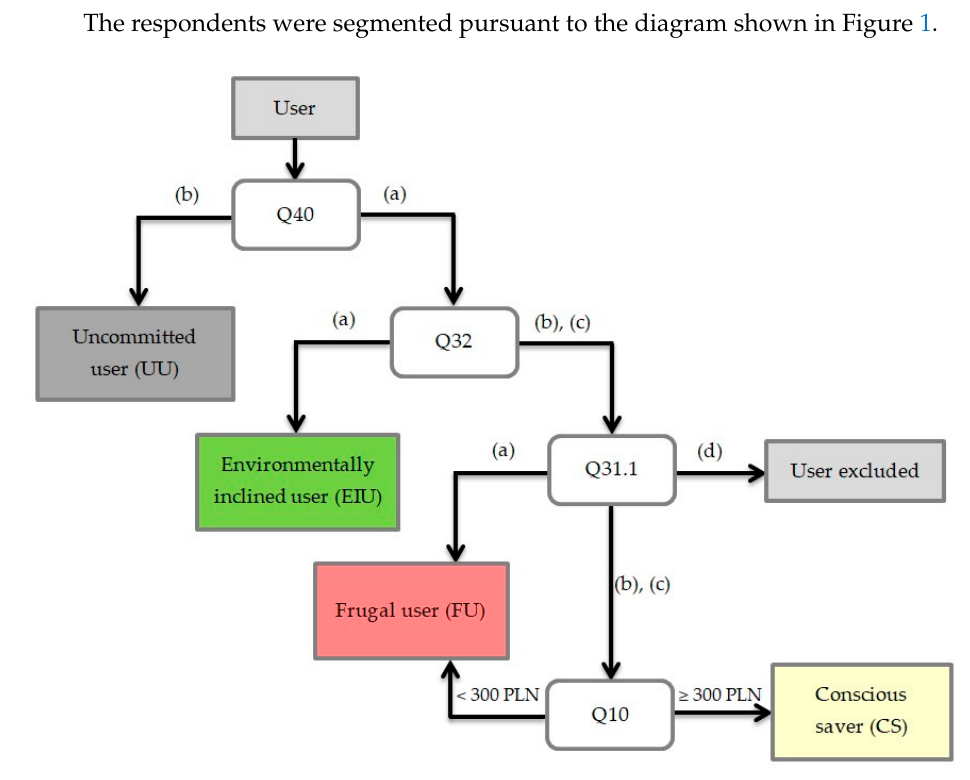
Figure 1. Diagram showing the process of dividing (segmenting) respondents into 4